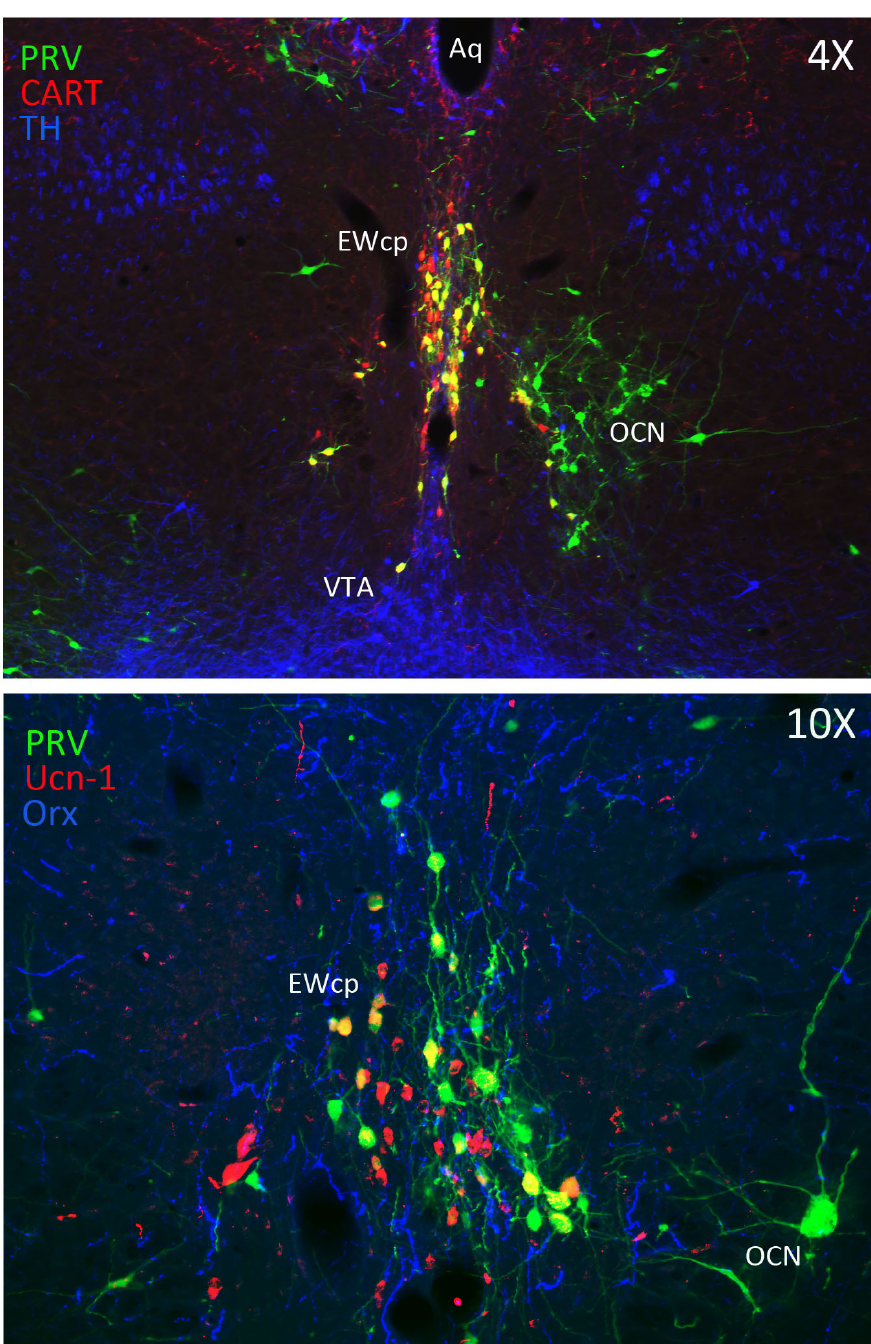
Figure 1. Infected neurons in the EWcp after PRV injection into BAT in rat. Brain sections were processed for triple immunofluorescence. Upper image shows infected neurons labeled in green, CART-ir neurons in red, and dopaminergic neurons (tyrosine hydroxylase-ir) in blue at low magnification (4×). Most infected neurons in EWcp are CART-ir (double-labeled in yellow), intermingled with some non-infected dopaminergic neurons (blue). Lower image shows infected neurons labeled in green, Ucn-1-ir neurons in red and Orx-ir fibers in blue at high magnification (10×). Dense Orx fibers appear in close contact with infected Ucn-1-ir neurons, which are double-labeled (yellow). Bregma level = − 6.00 mm (upper image) and − 5.62 mm (lower image) based on the rat brain atlas from Paxinos and Watson, 6th ed. [13]. Abbreviations: EWcp, Edinger-Westphal nucleus; Aq, aqueduct; OCN, oculomotor nucleus; TH, tyrosine hydroxylase; VTA, ventral tegmental area.